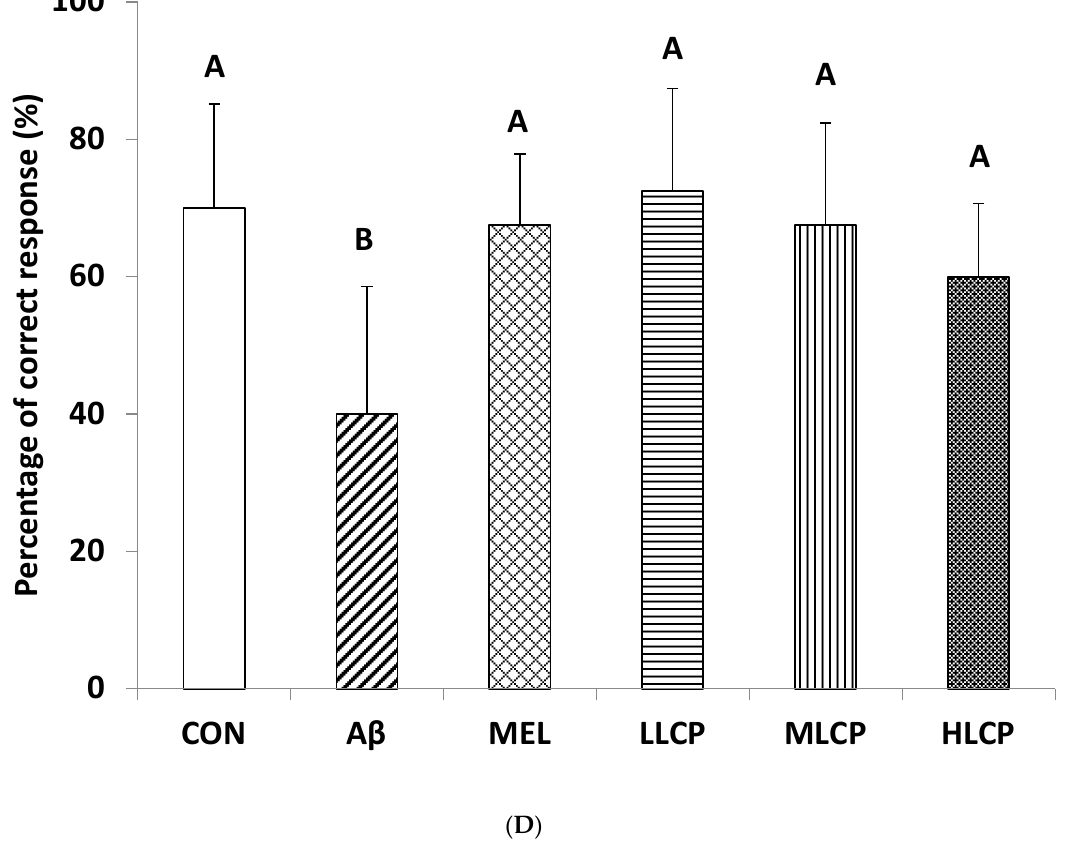
Figure 3. Effects of LCP fruit powder on behavior test in A β‐ induced Alzheimer’s mice. ( A ) The swimming path of probe task for each group. ( B ) Average swimming time (sec.) in target zone during probe task. ( C ) Average crossing frequency (times) in target zone during probe task. ( D ) The correct percentage of the path on the T maze discrimination task for each group. Values are expressed as mean ± SD ( n = 8). Means with different letters (A and B) are significant differences between the groups ( p < 0.05). Abbreviations: symbols are represented in Table 2.